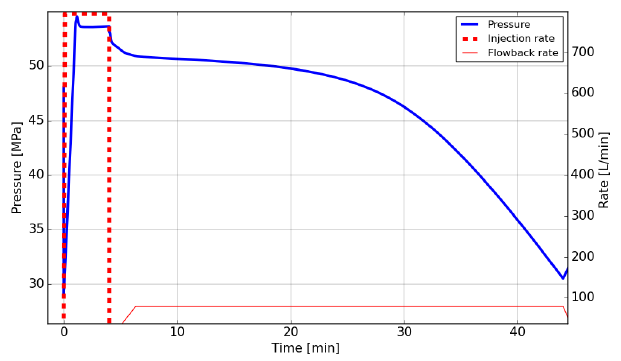
Figure 9. Pressure and rate for pump-in/flowback simulation case.